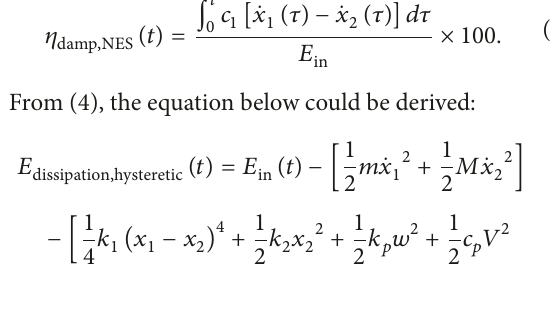
[10 8 , 10 9 ] and 𝑐 ∈ [10, 20] , 𝜂 1 harvest , piezo is obviously higher than others. The spring stiffness 𝑘 1 has no effect on 𝜂 harvest , piezo except for the distinct boundary when 𝑘 1 is about 10 8 N/m, while the damper 𝑐 1 is positively correlated with 𝜂 harvest , piezo in both